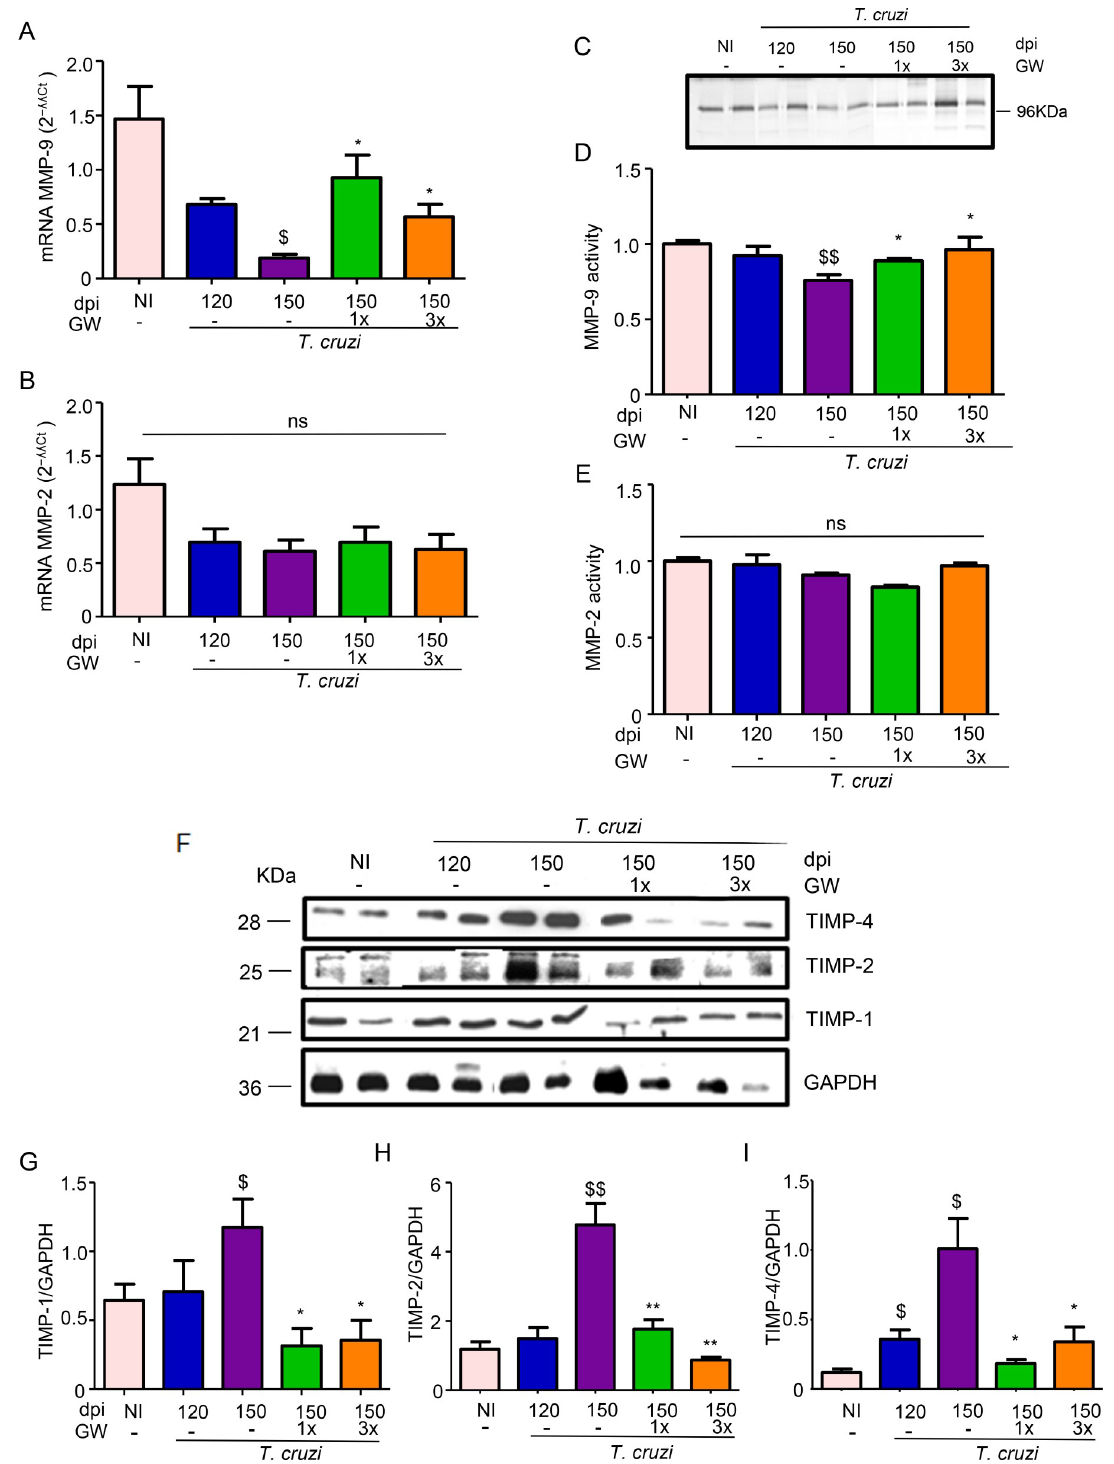
Fig 6. GW788388 treatment reverses MMP/TIMPs expression in the heart of mice chronically infected with T . cruzi after GW788388 treatment. Mice were infected with the Colombian T . cruzi strain (10 2 parasites). Treatment with GW788388 started on 120 dpi until 150 dpi in two administration schemes: once a week (GW1x) and three times a week (GW3x). Non-infected (NI) mice were monitored as a control group. (A) MMP-9 mRNA levels, (B) MMP-2 mRNA levels relative to GAPDH levels from hearts of infected mice (2 − ʎʎ Ct values, fold change) are plotted. (C) Representative zymography gel showing the gelatinolytic activity of MMP-9;